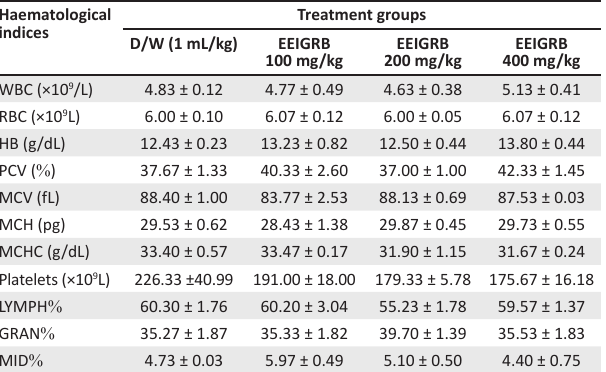
TABLE 1: Effect of 28 days of oral administration of ethanol extract of Irvingia gabonensis root bark on the haematological parameters of Wistar rats. Haematological indices